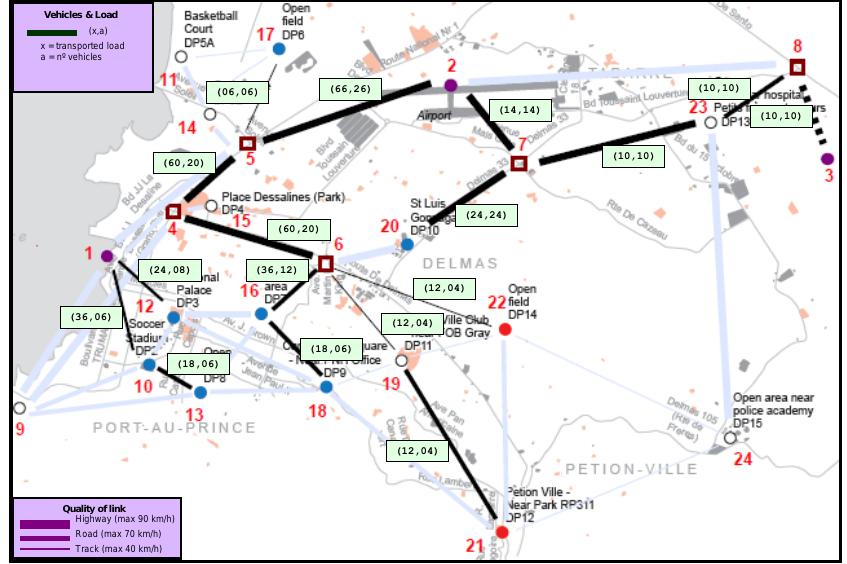
Fig. 2. Itineraries given by the static model on the original case study